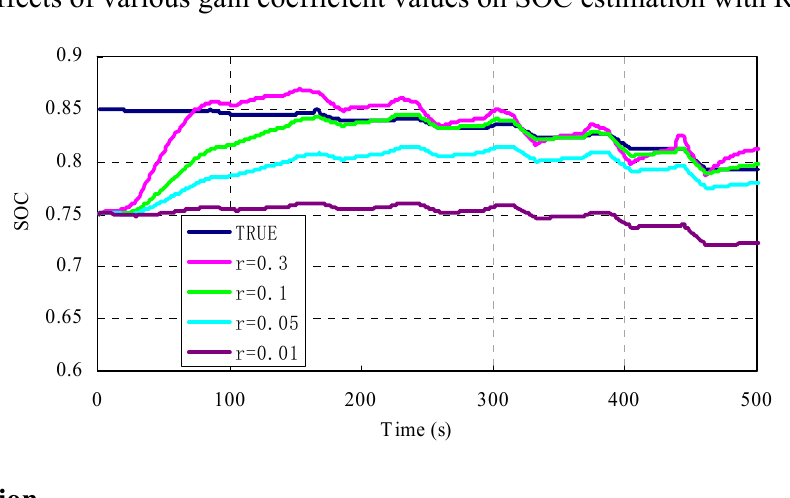
Figure 7. Effects of various gain coefficient values on SOC estimation with Robust EKF.